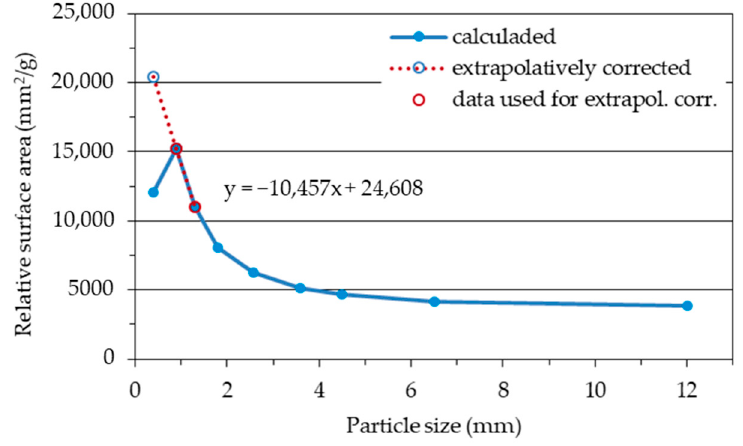
Figure 3. Visualization of the relative, related to one gram of dry wood particles, surface area.